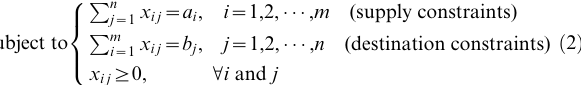
Figure 4. Treatment of objective: necessity-fractile